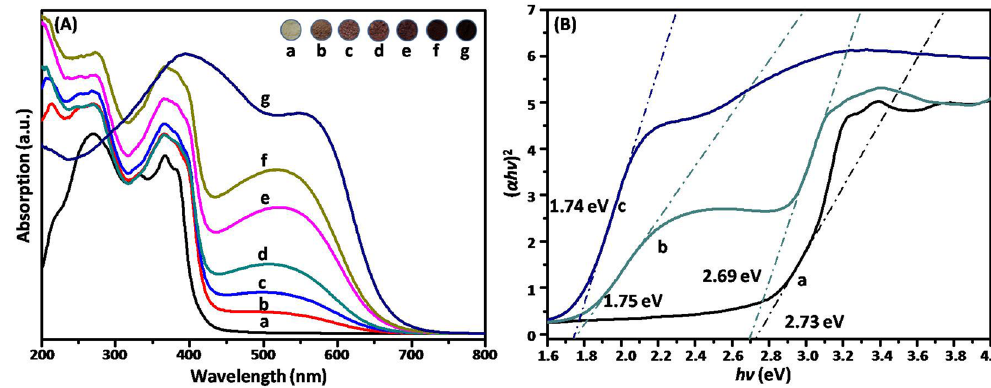
Figure 5. ( A ) UV–vis DRS (insert are the photos of samples) of (a) g-C 3 N 4 , (b) g-C 3 N 4 /Ag 2 CrO 4 (9.1%), (c)